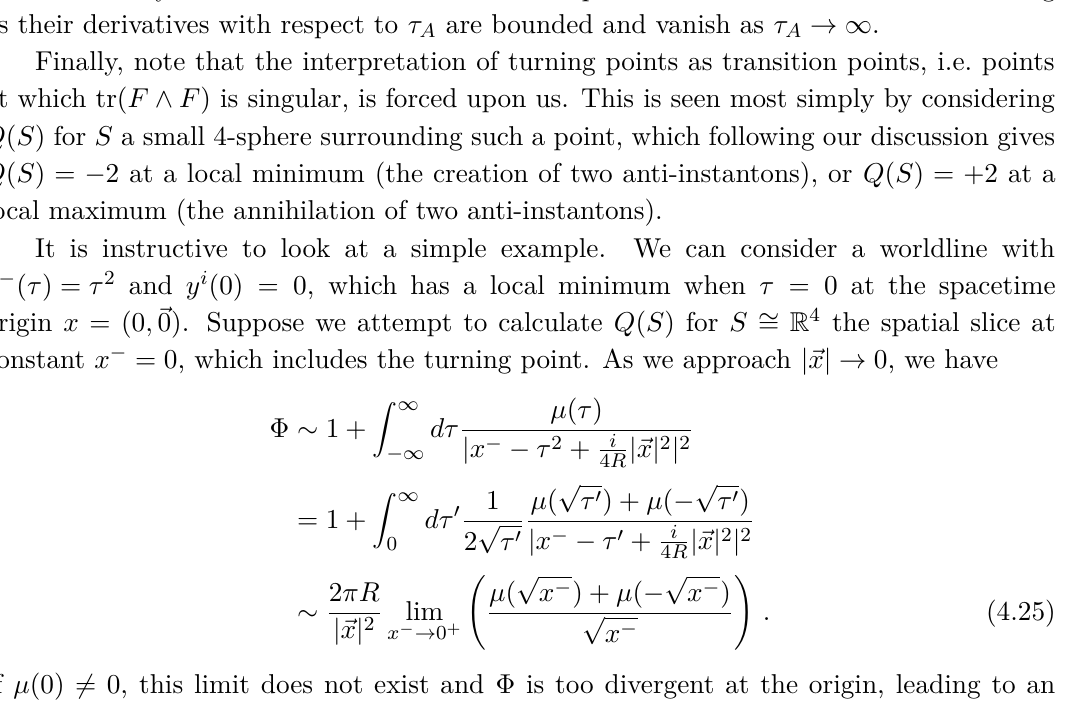
JHEP09(2021)086